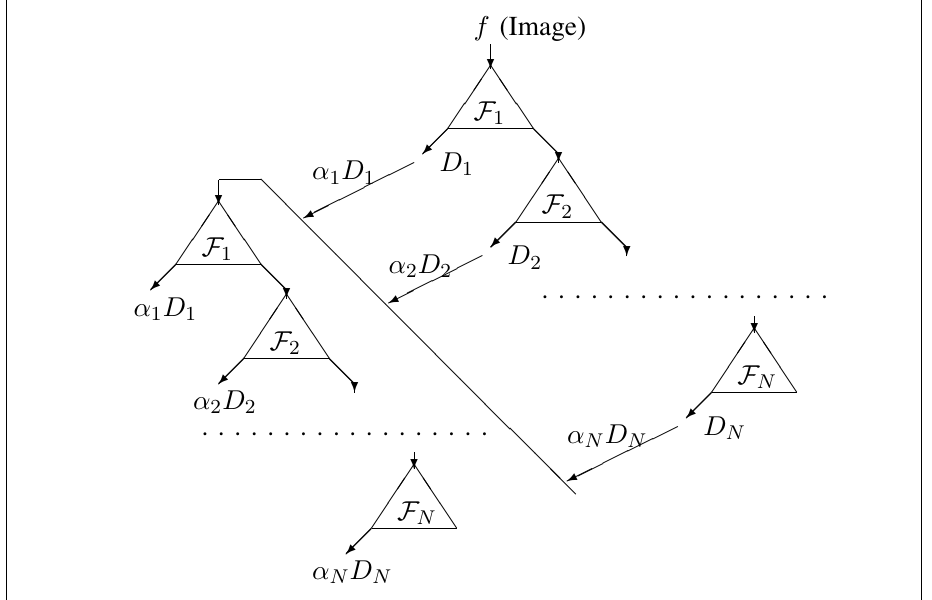
Fig. 2. Illustration of the Highlight